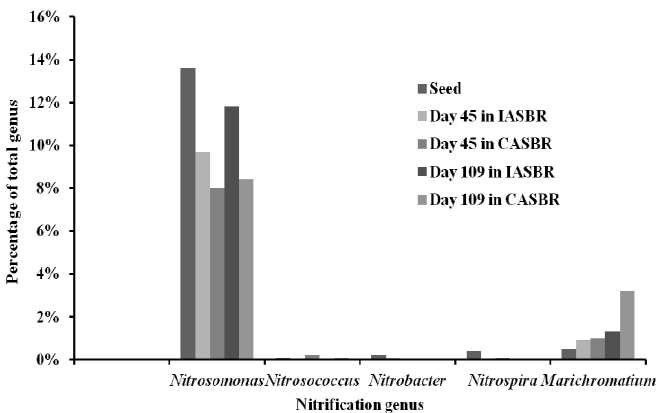
Figure 6. Microbial population analysis of nitrification genus in two SBRs.